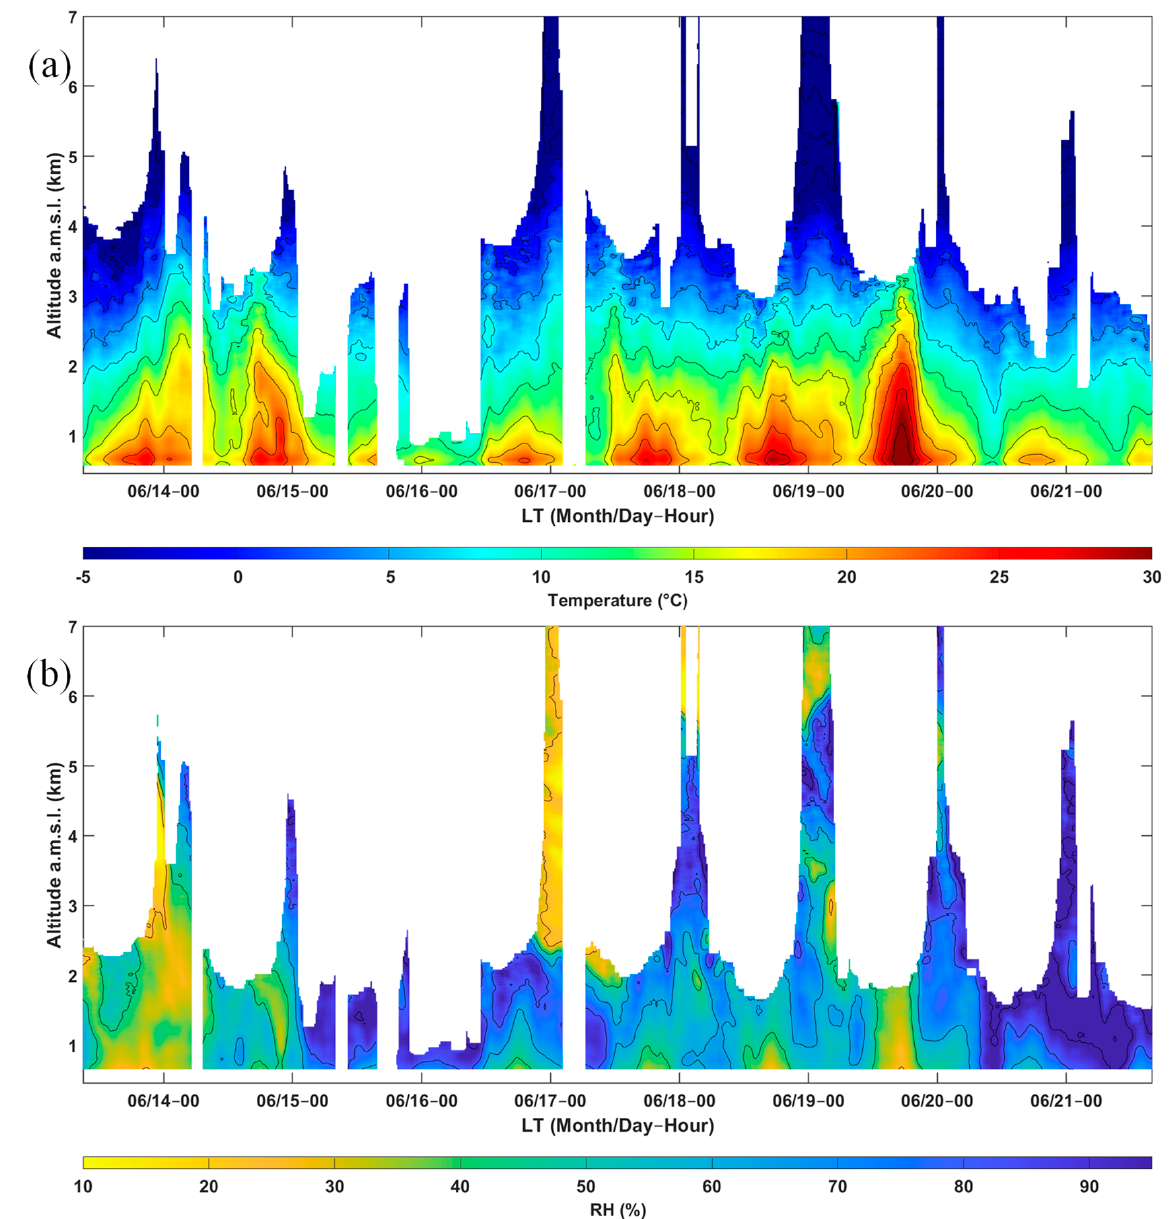
Figure 4. Temporal evolution between 13–21 June 2019 of the vertical profiles of lidar-derived ( a ) temperature and ( b ) relative humidity (RH). Maximum range is chosen based on a threshold on signal to noise ratio (SNR) and uncertainty. White time stripes correspond to periods of clouds.